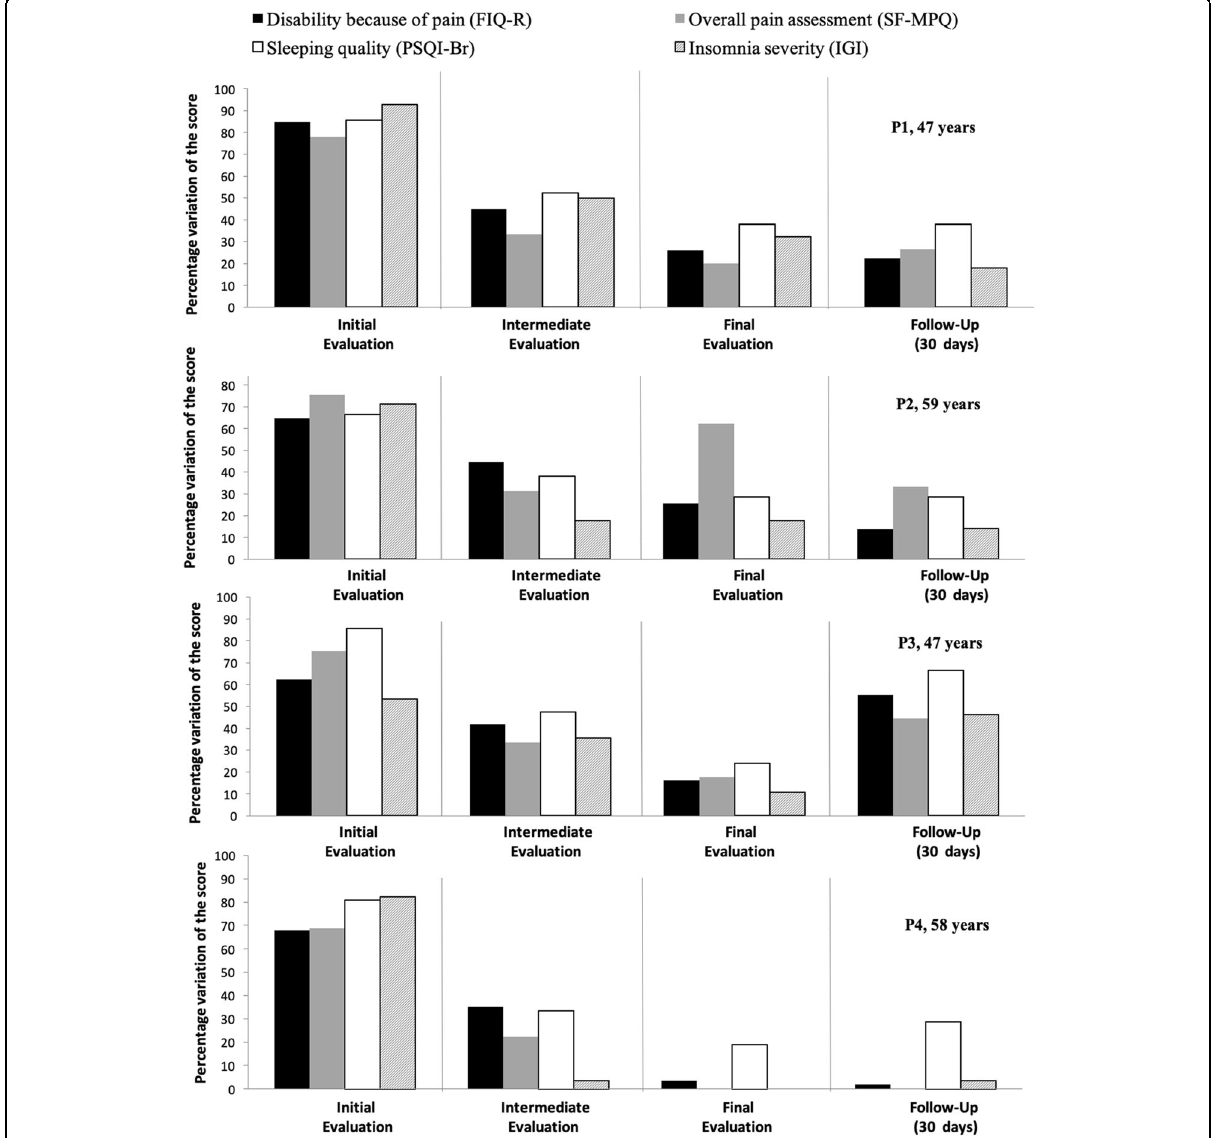
Fig. 3 Initial, intermediate, final, and follow-up assessment data expressed in percentages for each